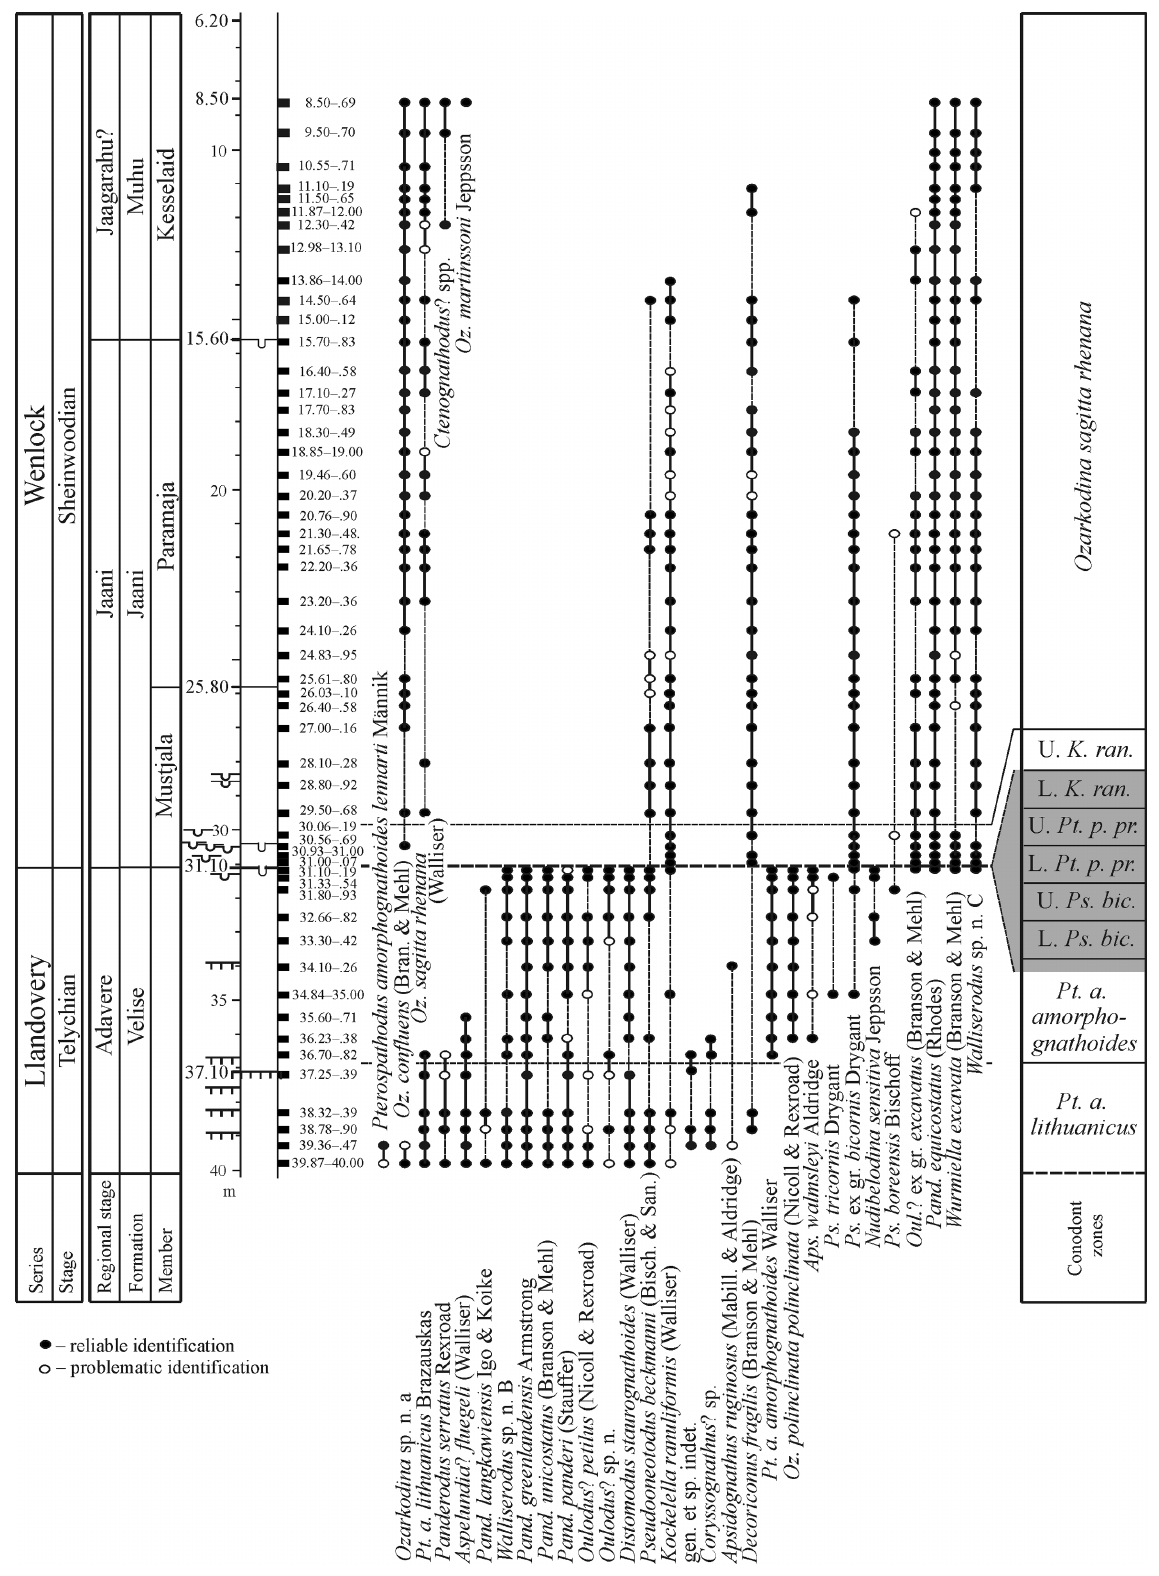
Fig. 5. Distribution of conodonts in the Suigu (S-3) core section. U., Upper; L., Lower; K. ran. , Kockelella ranuliformis ; Pt. p. pr. , Pterospathodus pennatus procerus ; Ps. bic. , Pseudooneotodus bicornis ; a. , amorphognathoides . For legend see Fig.